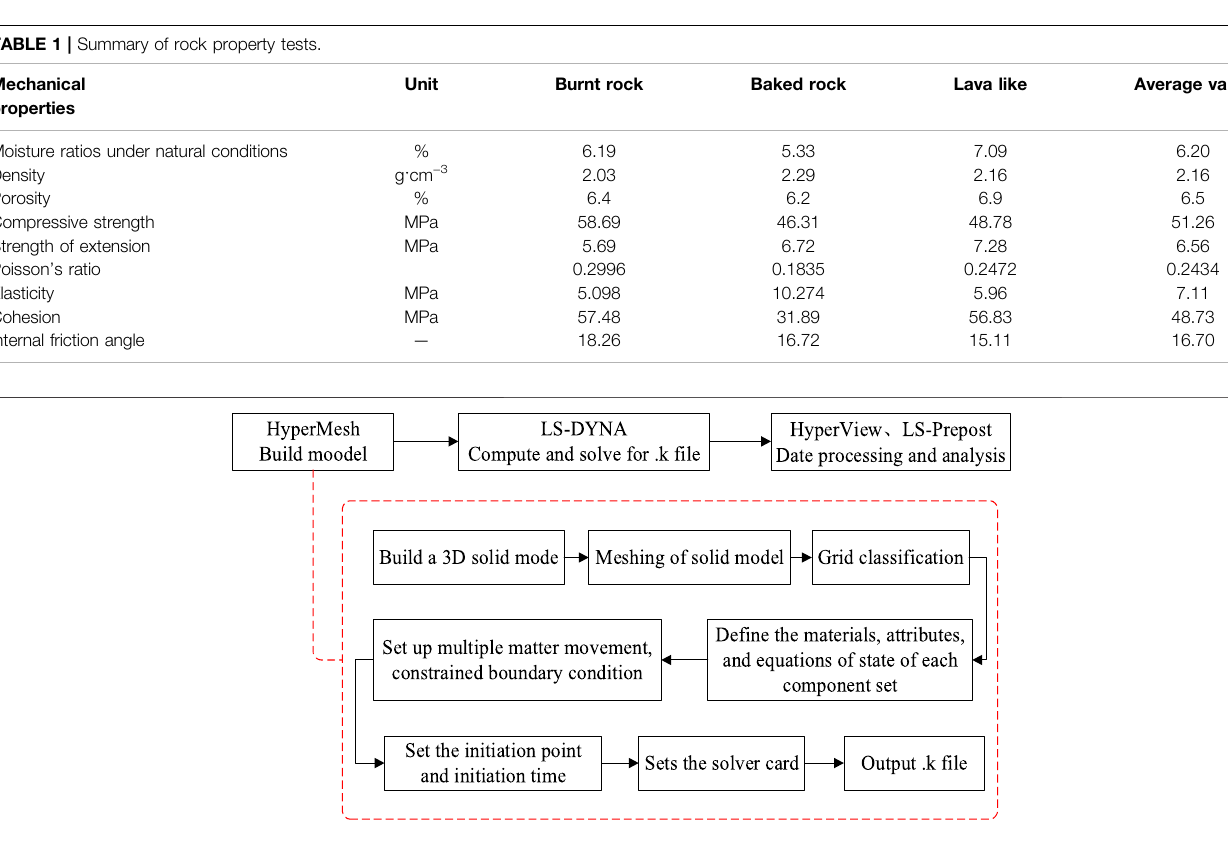
TABLE 1 | Summary of rock property tests.